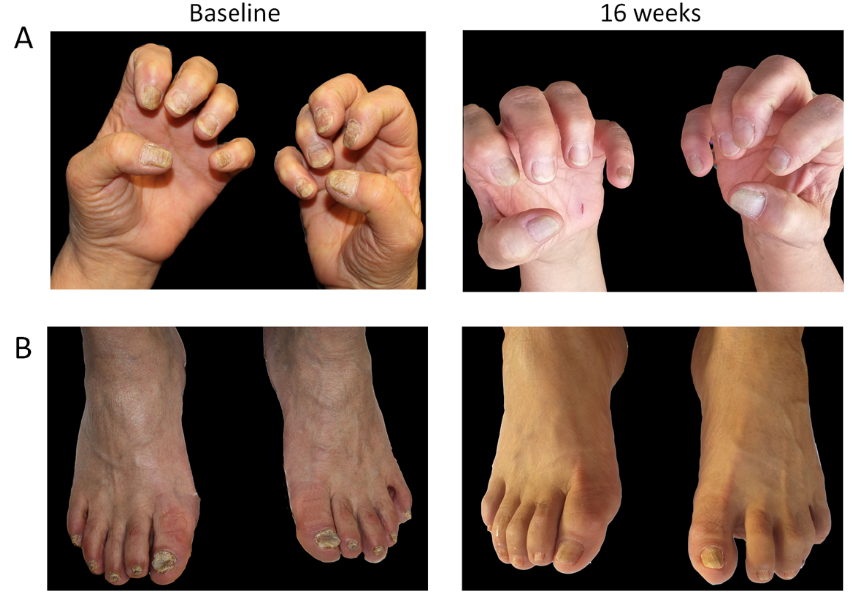
Figure 4. Representative images of outcome in Case #3; a female patient with severe hand ( A ) and foot ( B ) nail involvement. After 16 weeks of tildrakizumab treatment, both PASI score and NAPSI index decreased from 10 to 0 and from 160 to 86, respectively.